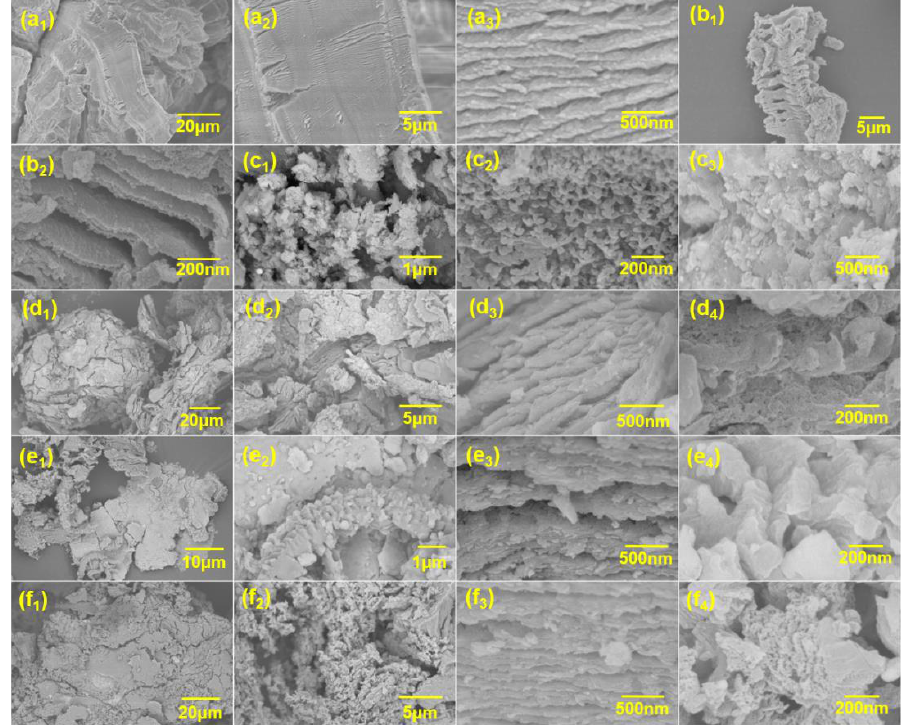
Figure 8. SEM images of intermediate by-products of Al-LMP and Al-LMP-NiCl 2 ball-milled com- posites ( a 1 ) block, ( a 2 , a 3 ) amplified images of a 1 ; ( b 1 ) powders, ( b 2 ) amplified image of b 1 ; ( c 1 ) 0% NiCl 2 (1 h), ( c 2 , c 3 ) amplified images of c 1 ; ( d 1 ) 2% NiCl 2 (1 h), ( d 2 – d 4 ) amplified images of d 1 ; ( e 1 ) 2% NiCl 2 (2 h), ( e 2 – e 4 ) amplified images of e 1 ; and ( f 1 ) 2% NiCl 2 (3 h), ( f 2 – f 4 ) amplified images of f 1 .